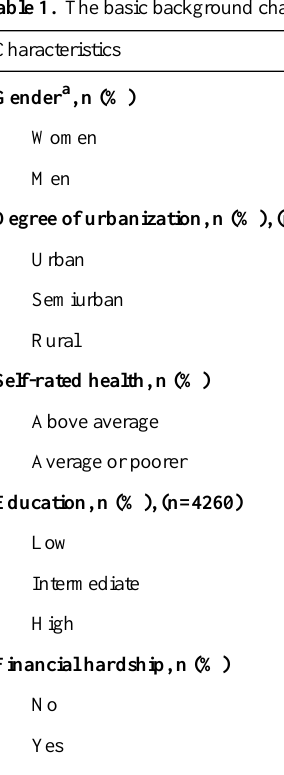
Table 1. The basic background characteristics of the weighted study sample